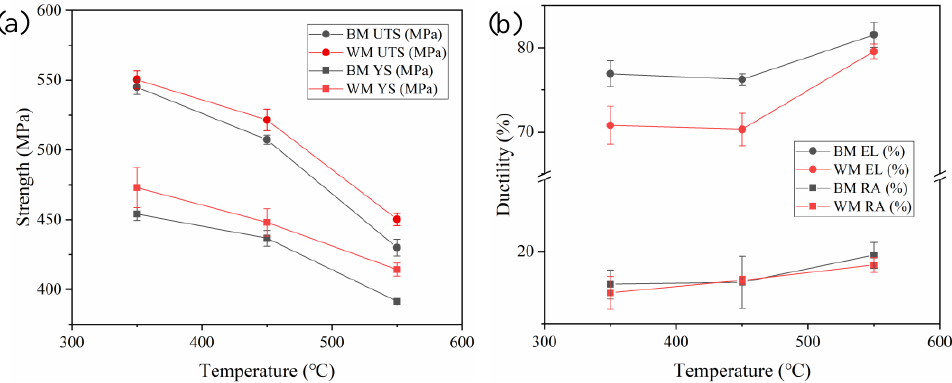
Figure 4. Variation of ( a ) strengths (YS and UTS) and ( b ) ductility (EL and RA) of 2.25Cr1Mo0.25V steel BM and WM as a function of temperature.